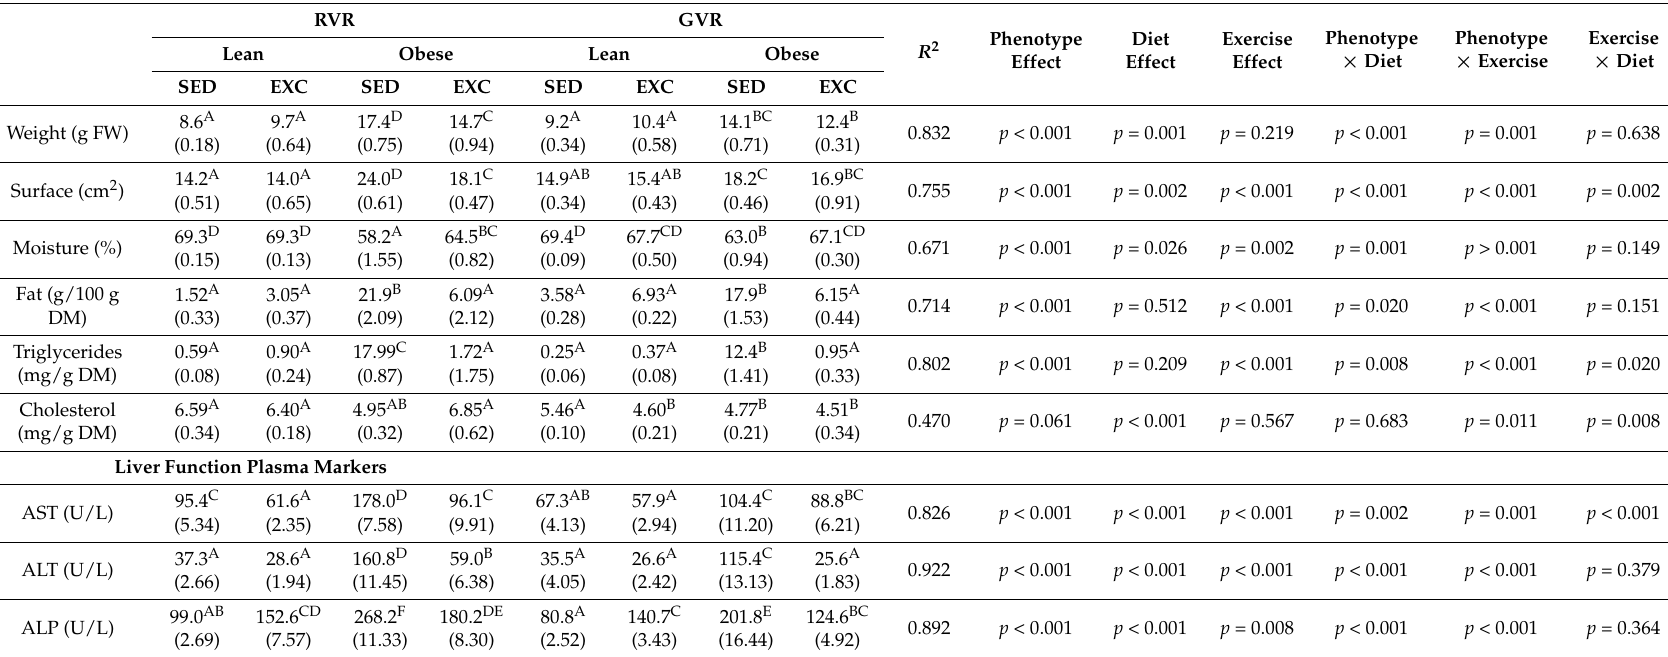
Table 5. Effect of phenotype, diet, and aerobic interval training protocol on liver weight, chemical composition, and